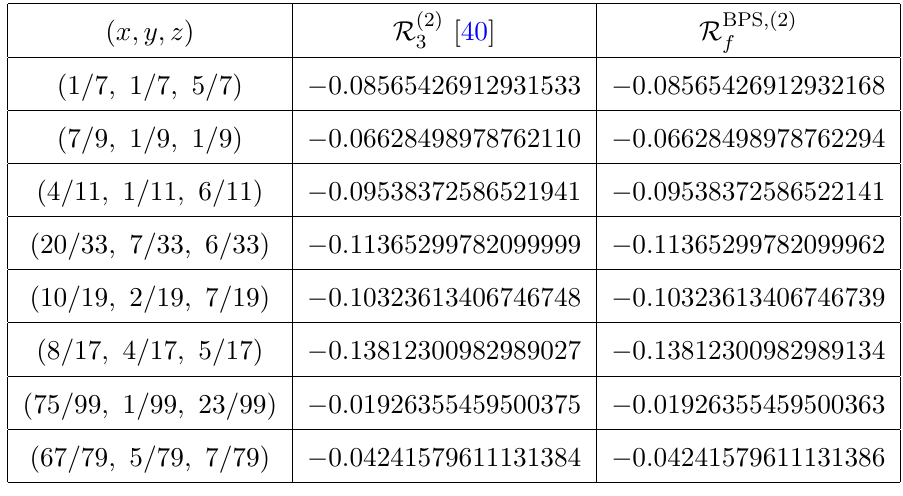
Table 1 . Numerical comparison of eq. (4.32) of [40] against our eq.